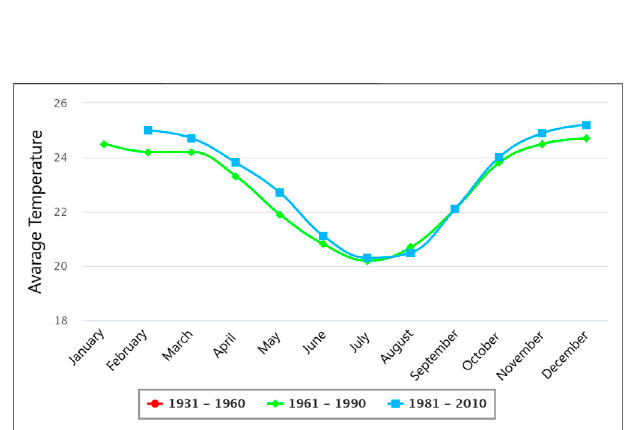
FIGURE 5 | Comparative graph of historical variations in average temperature ( o C) in the Pernambuco State in three annual intervals of 30 years. Source: Adapted from INMET